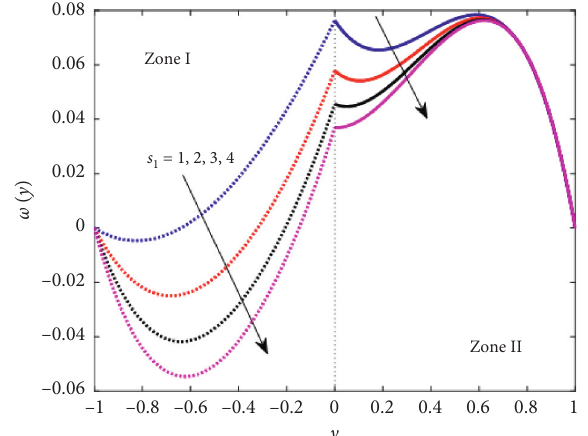
Figure 9: Microrotation profiles for various s